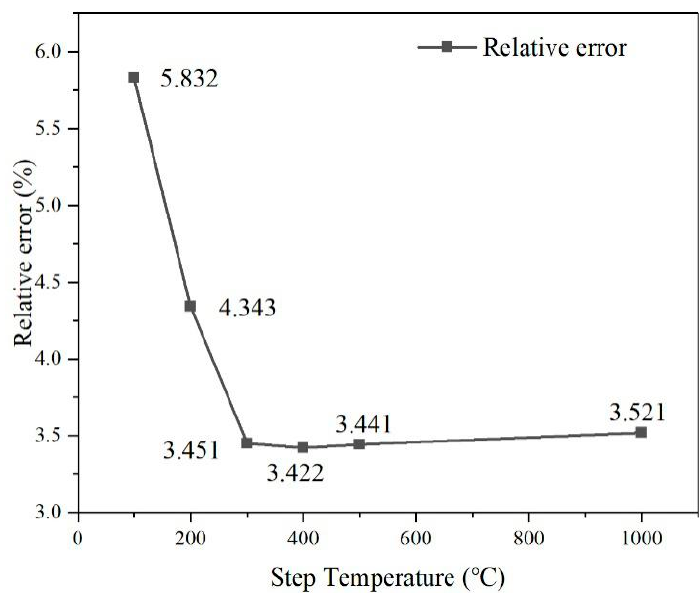
Figure 17. Relative error as a function of step temperature.